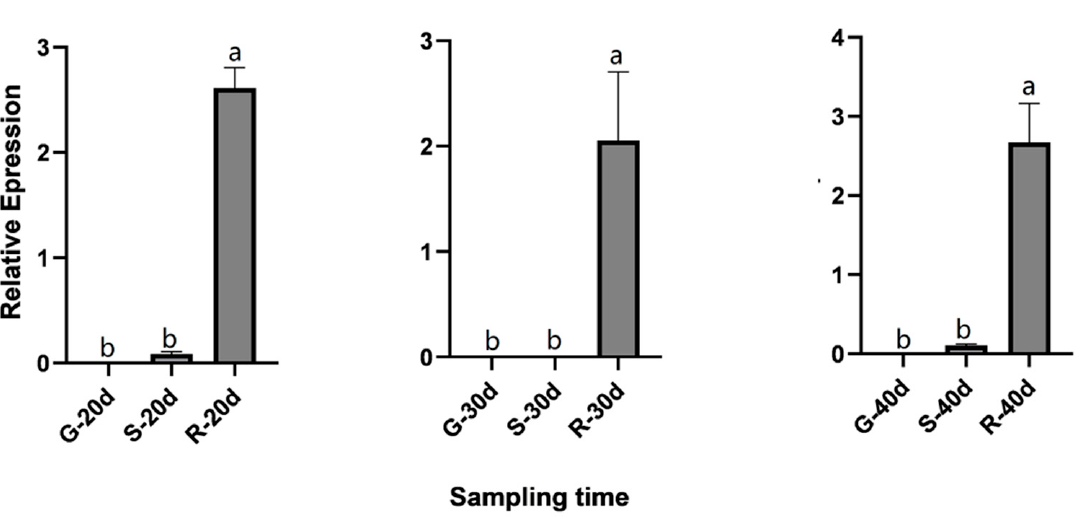
Figure 11. Relative expression levels of UFGT1 genes at the same stage in different cultivars. R, FZ-72 (red calyx); G, Baitao K (green calyx); S, MG5 (stripped calyx). Bars marked with the same and different letters indicate non-significant and significant differences, respectively. The significance level is α = 0.05.